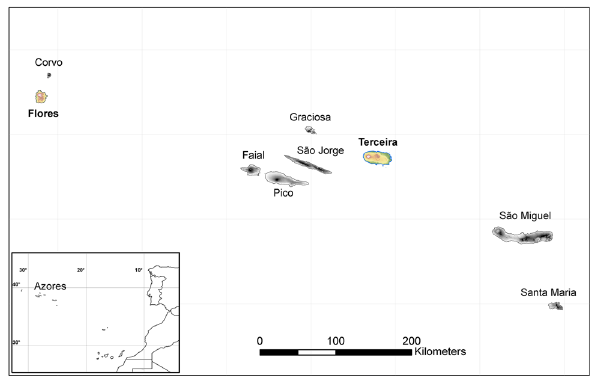
Fig. 1 Location of Azores archipelago within Atlantic Region and location of studied islands (Terceira and Flores) in the